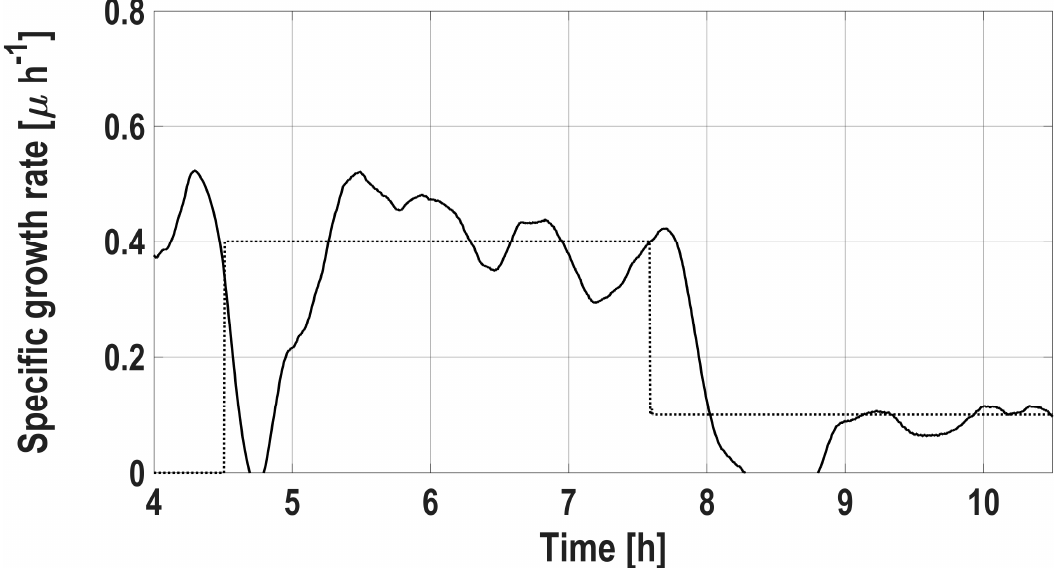
Figure 7. Setpoint (dash line) and estimated specific growth rate (solid line) during a controlled fed-batch culture, controller logic (Equation (10)). Processes 2020 , 8 , x FOR PEER REVIEW